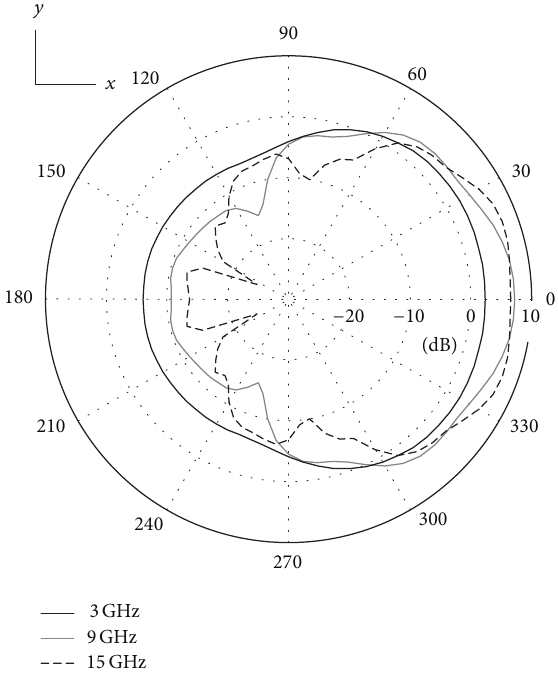
Figure 7: Radiation pattern of a conical antenna with elliptical aperture displaced of 40 mm in the xy plane.